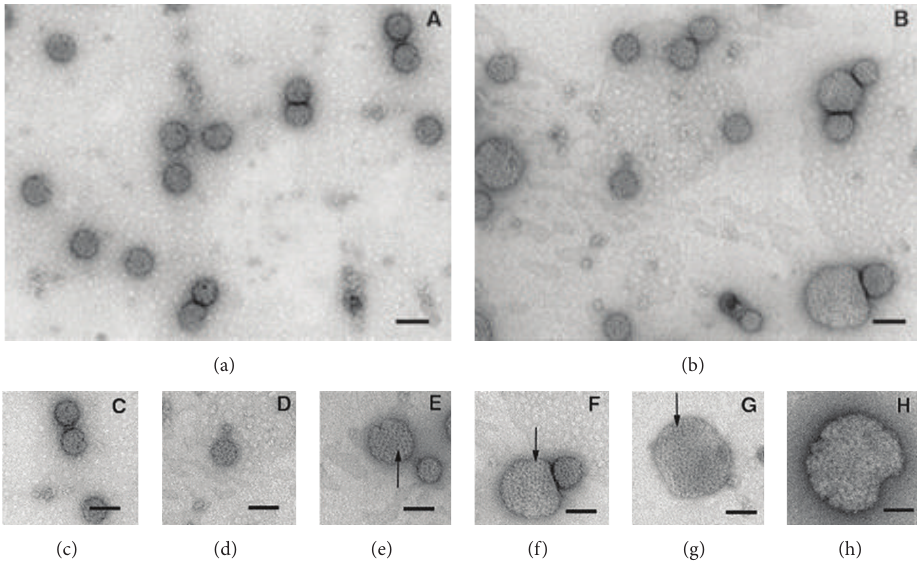
Figure 6: Electron micrographs of negatively stained virus particles recovered from the supernatant of BHK cells transfected with either Sindbis virus S420Y ((a) and (c)) or Y180S/E183G ((b), (d), (e), (f), (g), and (h)). (a) and (b): a wider view of the fields. (c)–(h): individual particles arranged to show examples of the various sizes found for the Y180S/E183G mutant ((d)–(h)) as compared to the control S420Y particle (c). Arrows point to morphological units. Bars, 100 nm. Ferreira et al. 2003